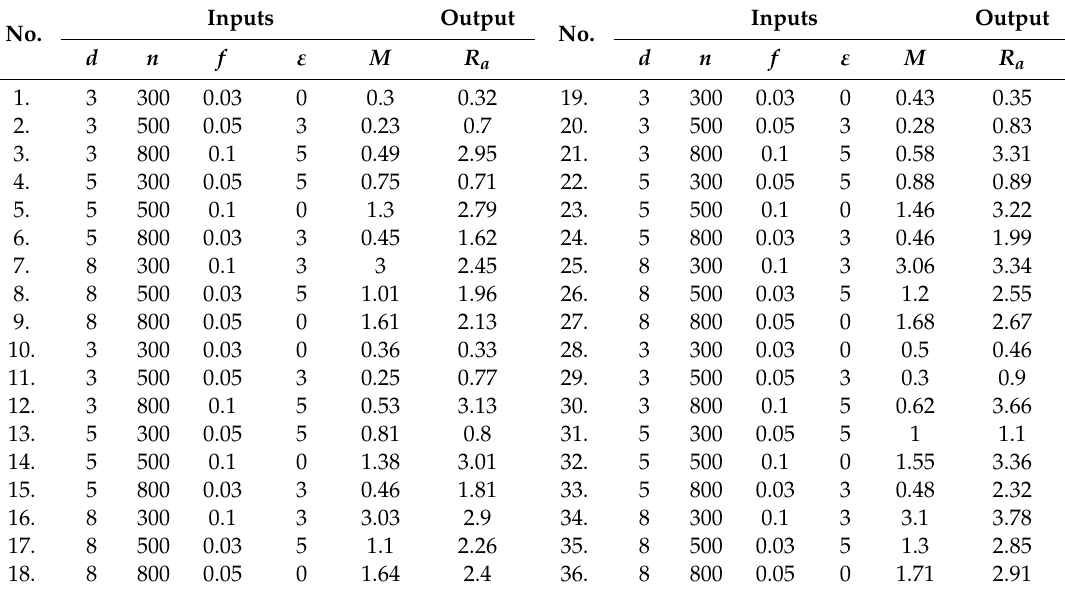
Table 11. Training data for artificial neural networks